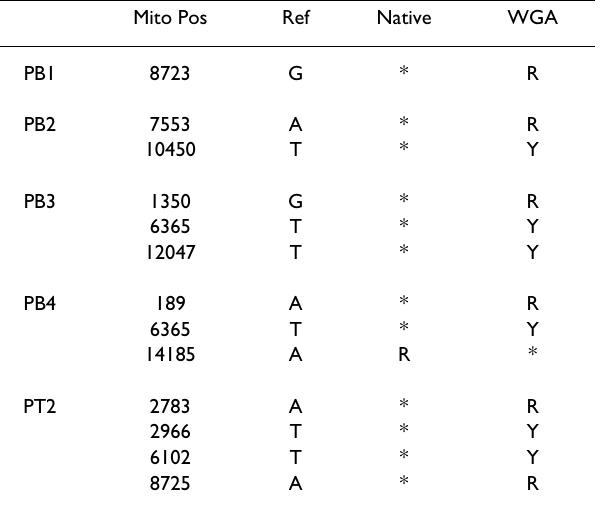
Table 4: Discrepant